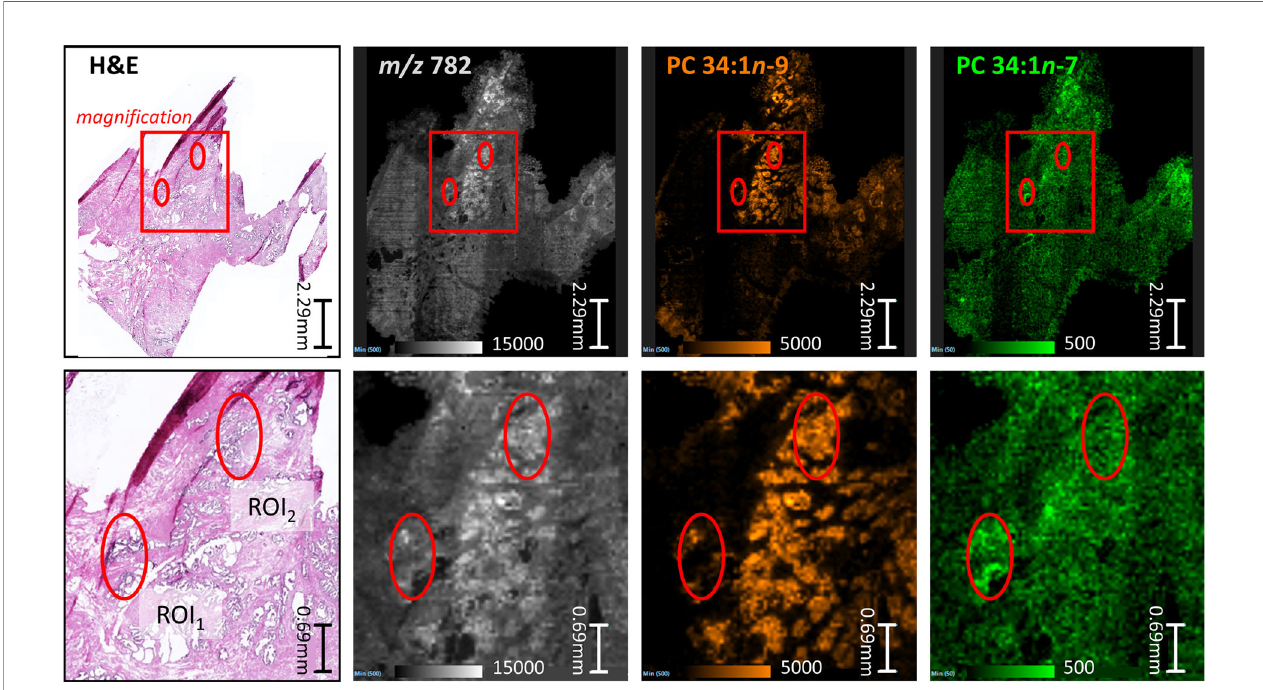
FIGURE 2 | Comparison between serial sections of a prostate tissue following either routine staining (H&E) or MALDI-MSI-OzID. Top row: red box indicates the magni fi ed region show in the bottom row, and ellipses provide comparative reference points. (Pink/purple) Prostate tissue H&E stain and micrograph with ROIs independently determined by two pathologists as in fl ammation (ROI 1 ) or abnormal prostate epithelia (ROI 2 ); (White) MALDI-MSI image showing the distribution of all product ions of m/z 782; (Orange) Isomer-resolved MALDI-MSI distribution of PC 34:1 n -9 identi fi ed from OzID product ion at m/z 672; (Green) Isomer-resolved MALDI-MSI distribution of PC 34:1 n -7 identi fi ed from OzID product ion at m/z 700. Each pixel within the MSI images is a spectrum similar to Figure 1 , and thus each image show a product ion spectral intensity mapped across the tissues. Displayed product ion m/z was within 5 ppm of theoretical